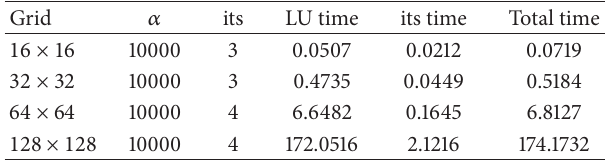
Table 2: Preconditioned GMRES(20) on steady Oseen problems with different grid sizes (uniform grids), viscosity V = 0.1 .